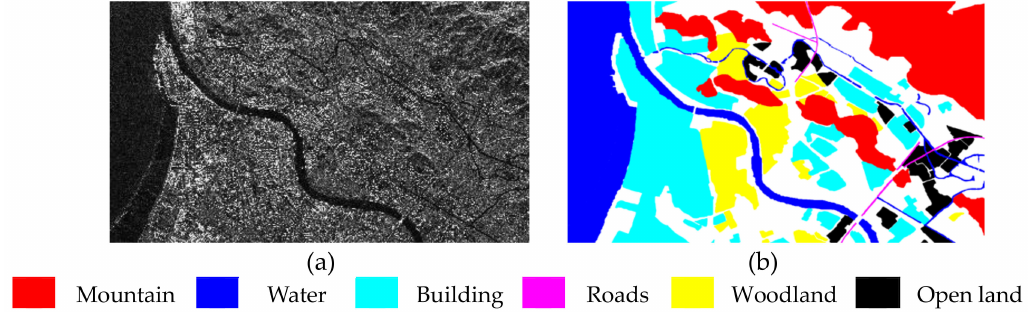
Figure 6. Gaofen-3 SAR image. ( a ) Original SAR image. ( b ) Ground-truth. Airborne data: The third group of data is obtained from Chinese airborne covering the area of Shaanxi province, China, with Ku-band. The image is HH-polarization data with spotlight mode. The data were provided by the China Electronics Technology Group Corporation (CETC) Institute. The pixel size of this image size is 1800 × 3000 pixels, and the spatial resolution is 0.3 m. Seven categories are included, which are open land, roads, rivers, runway, woodland, residential, and commercial. The original image and the ground-truth image are shown in Figure 7a,b.